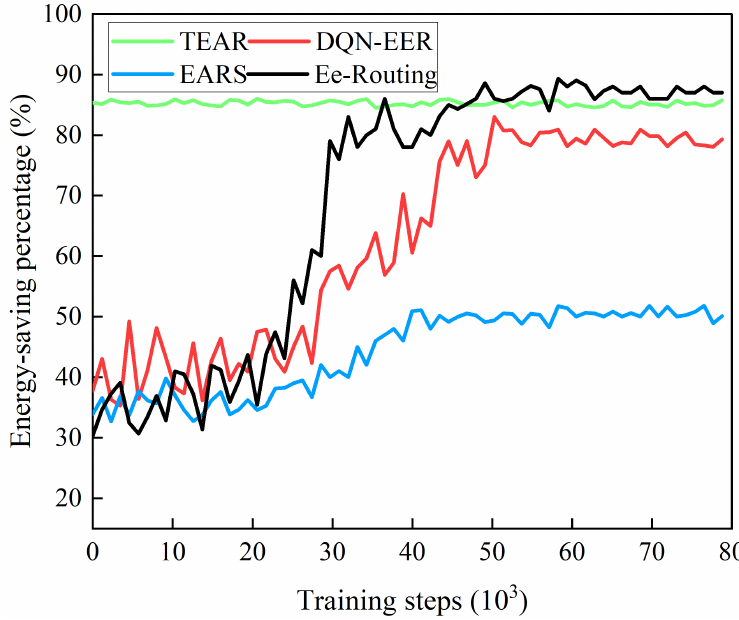
Figure 5. Energy-saving percentage under 20% traffic intensity.